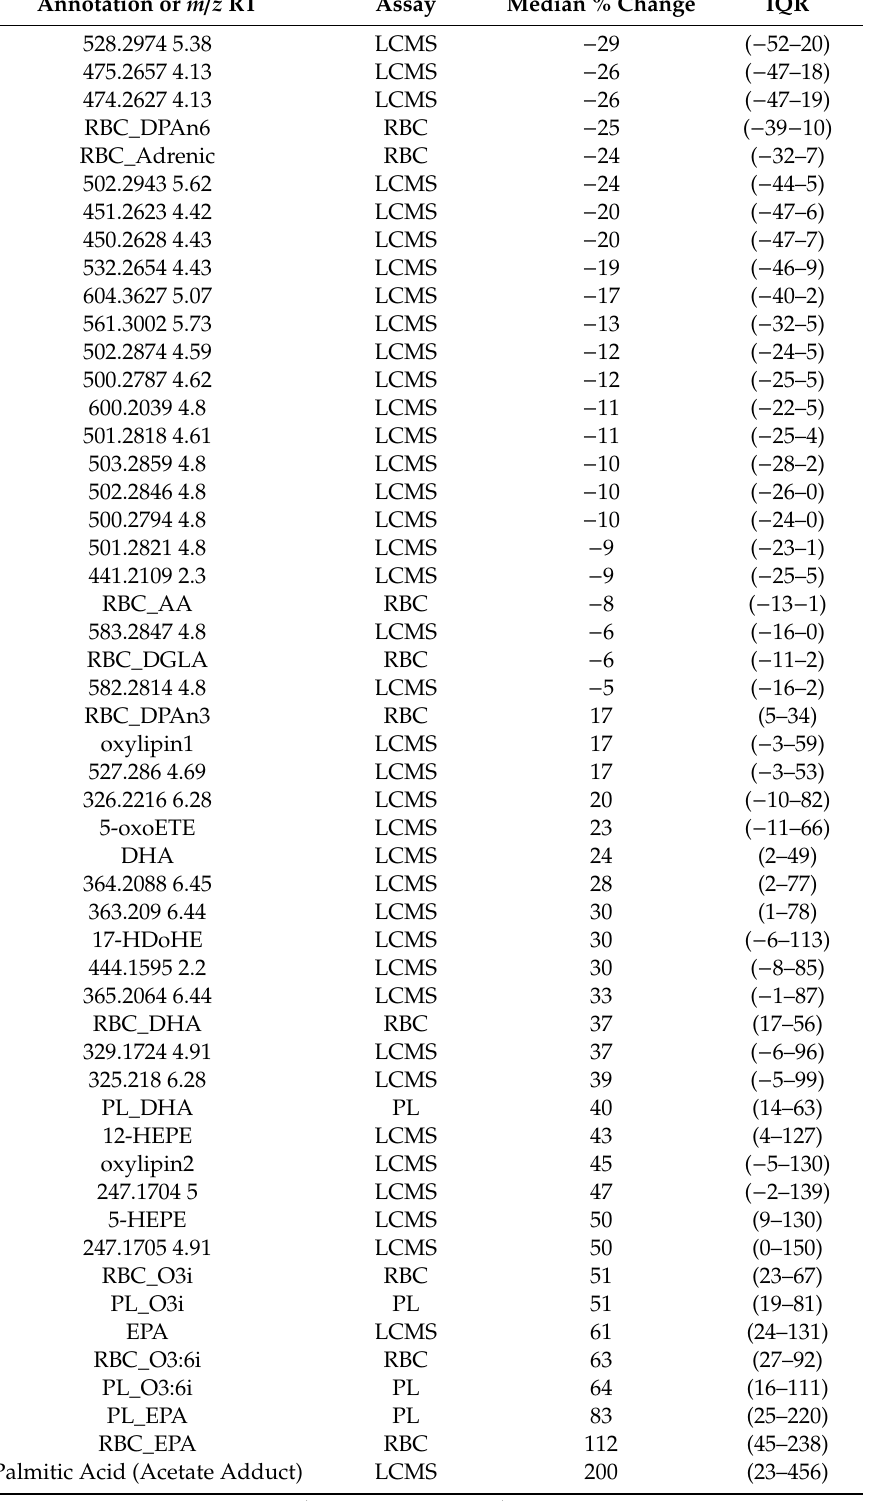
Table A2. n-3 treatment e ff ect on one-year percentage change in FAs, oxylipins and small bioactive lipid features in